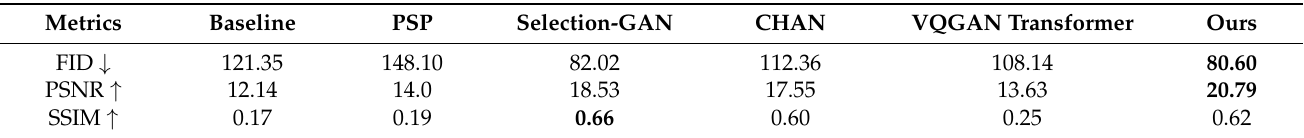
Figure 12. Scatter plot of generated and real pixel values. ( a ) a red band; ( b ) a green band; ( c ) a blue band. Table 3. Evaluation metrics comparison under a complicated scenario.